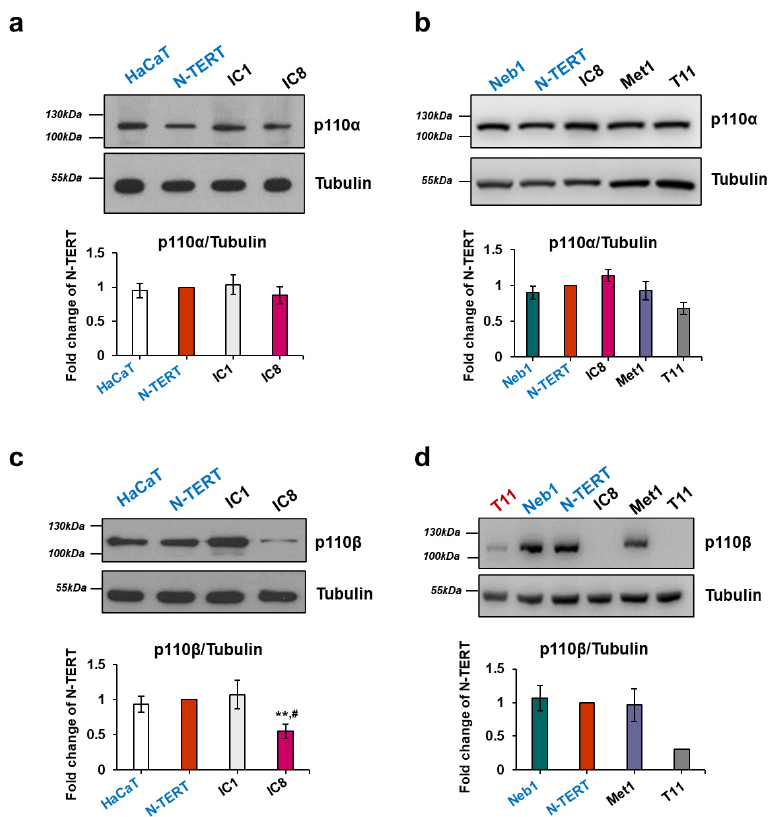
Figure 1. Keratinocyte and cutaneous squamous cell carcinoma (cSCC) cell lines express class I phosphoinositide 3-kinase (PI3K) isoforms p110 α and p110 β . Immortalized keratinocytes (HaCaT, N-TERT and Neb1, labelled in blue) and cSCC cells (IC1, IC8, Met1 and T11) were lysed with 2% SDS and expression of the indicated class I PI3K isoforms was analyzed by Western blotting. Tubulin was used as loading control. Signals were visualized using X -ray films and a film processor ( a , c ) or using Chemidoc™ MP Imaging System ( b , d ). Representative blots are shown. Graphs indicate data from densi- tometry analysis for each enzyme, normalized to Tubulin and expressed as fold change of results from N-TERT cells. Data are means ± SEM from the following numbers of lysates, prepared independently from different batches of cells: n = 6 (( a ), apart from IC1, n = 5), n = 3 ( b ), n = 6 ( c ) and n = 3 (( d ), apart from T11, n = 1). Note that p110 β was barely detectable and not quantifiable in IC8 cells using Chemidoc™ MP Imaging System ( d ) therefore densitometry analysis could not be per- formed for these cells in these experiments. Similarly, the band was detectable and quantifiable in only one of the T11 lysates in these conditions therefore only this set (labelled in red) was used for analysis in ( d ). See also Supplementary Figure S1d. ** p < 0.01 vs. N-TERT, # p < 0.05 vs. HaCaT.